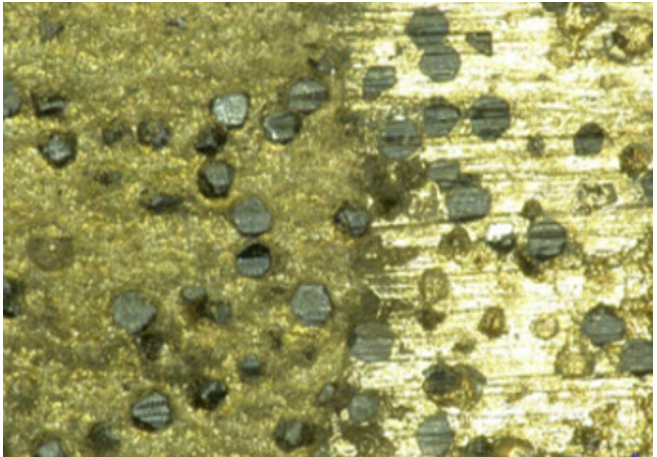
Figure 14. Schematic diagram of laser dressing diamond abrasive grinding wheel.